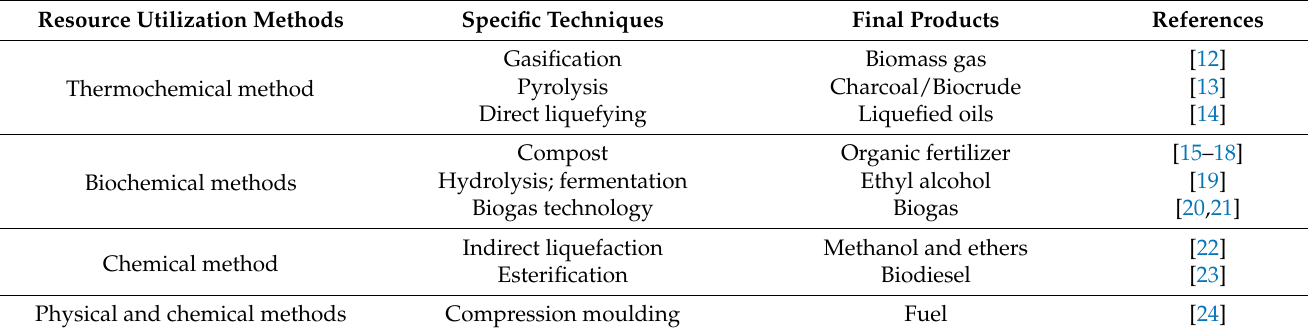
Table 1. Biomass waste resource utilization methods and products.